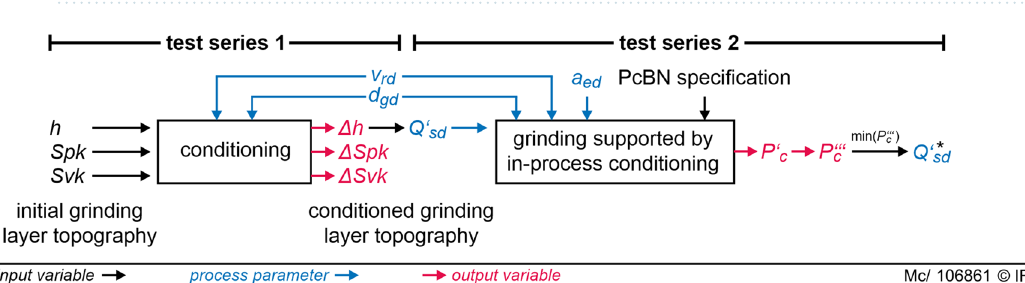
Figure 2. Dependencies between parameters and variables in the test